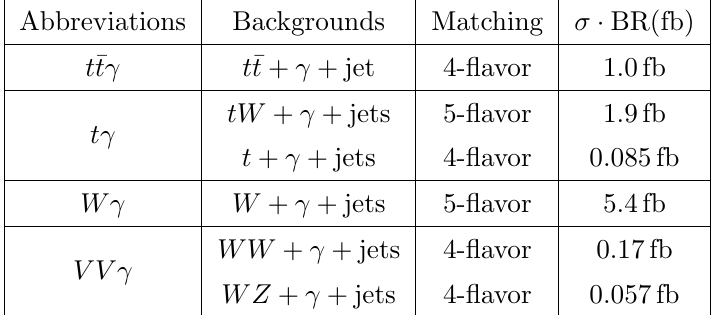
Table 3 . The summary of the SM backgrounds relevant to the ttg(cid:13) channel and their cross section after generation level cuts eqs. (4.3){(4.6). Matching refers to the either the 4-(cid:13)avor or 5-(cid:13)avor MLM matching [65]. The last column (cid:27) (cid:1) BR denotes the production cross section (in fb) times branching ratios including the top, W , and Z